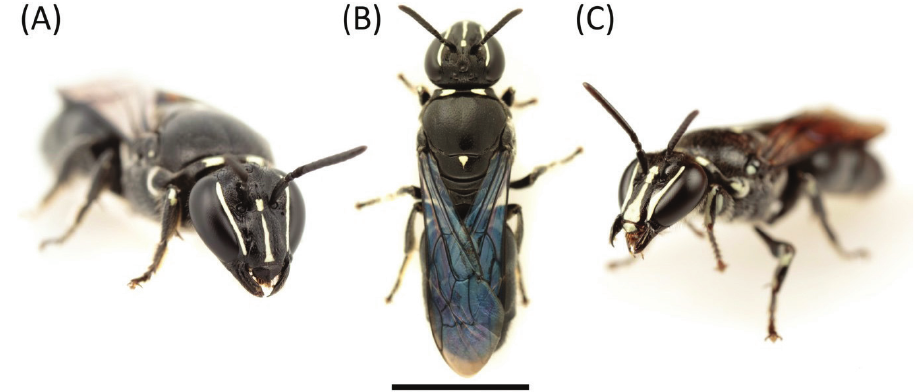
Figure 3. An A oblique and B dorsal photo of a female and an C oblique photo of a male Pharohylaeus lactiferus . Scale bar: 5 mm ( B ). Photos are not to